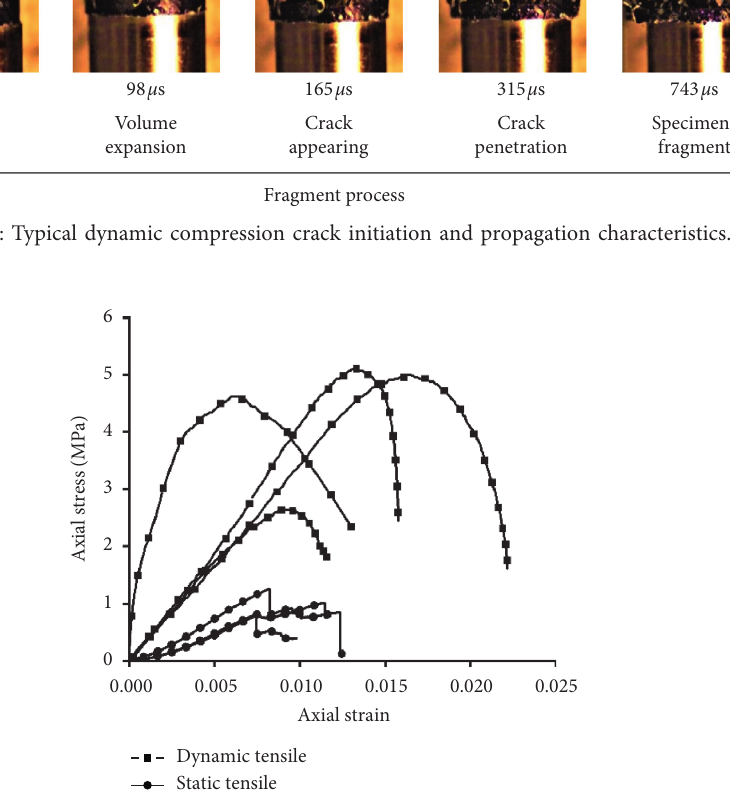
Figure 10: Comparison of dynamic and static tensile stress-strain